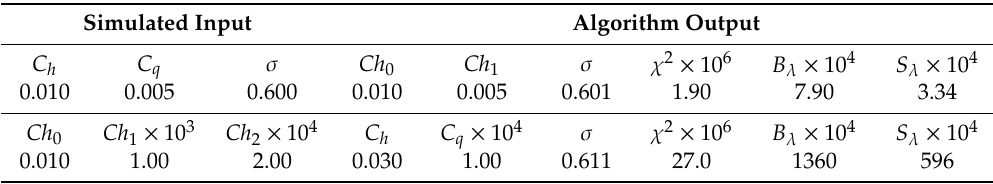
Table 3. Comparison of inputs and corresponding outputs to show the algorithm’s sensitivity to wavelength scale parameters (using shift / squeeze or shift